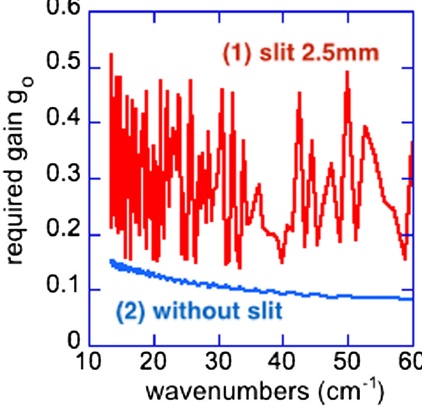
vs wavelength, (1) with o